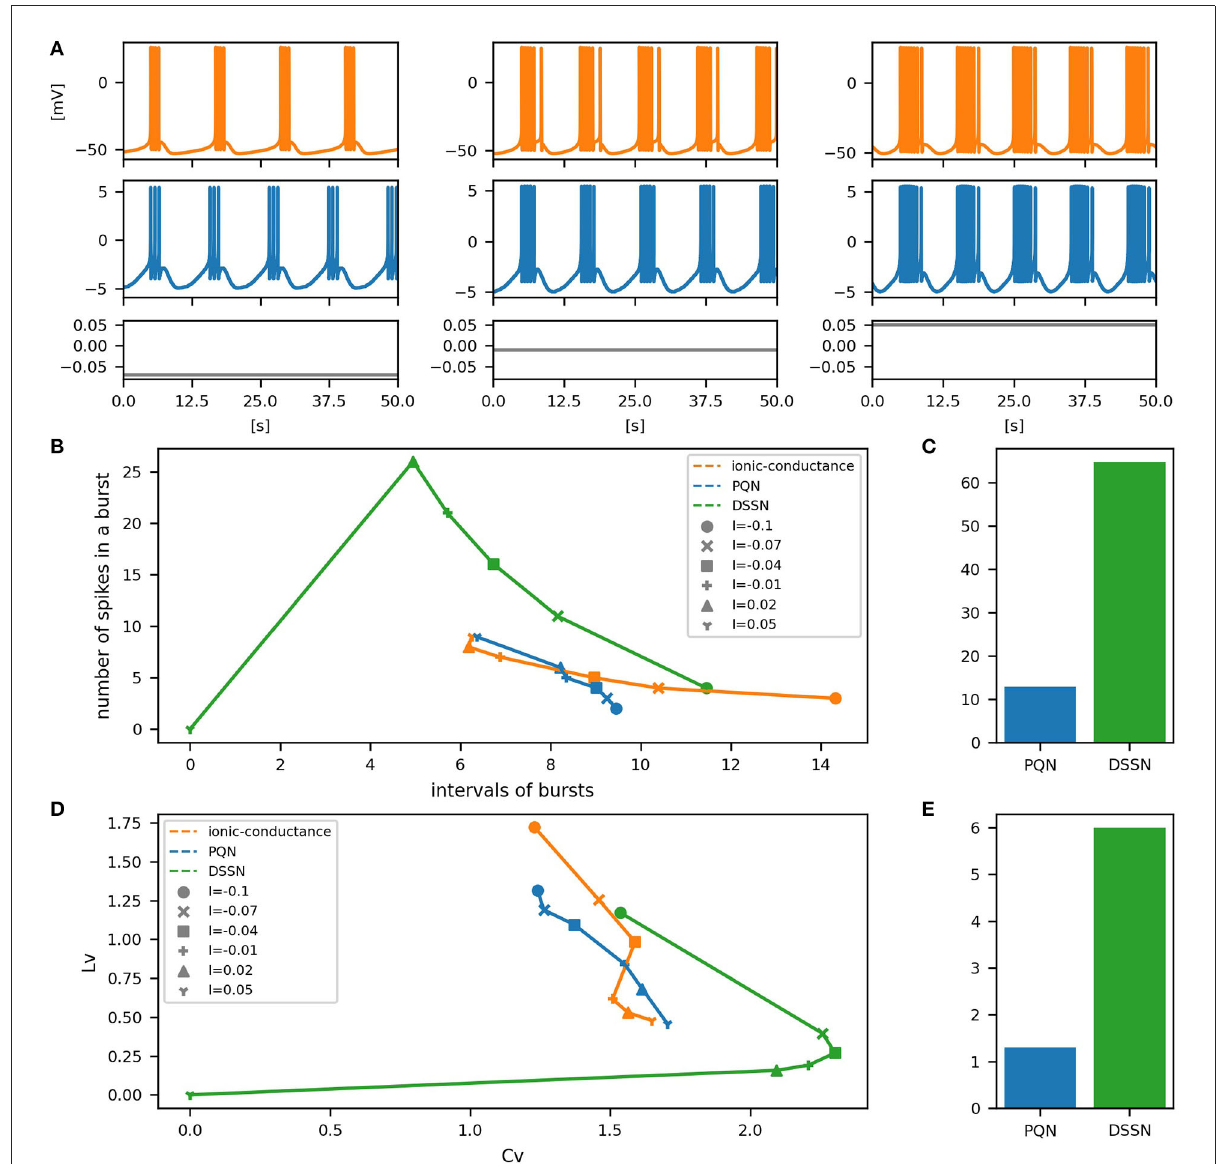
FIGURE12 Waveforms and spiking properties in PB mode. (A) Waveforms of the ionic-conductance model (orange) and the PQN model (blue). Gray lines represent stimulus inputs. (B) Properties of bursting. The horizontal axis represents the interval between bursts, and the vertical axis represents the number of spikes in a burst. Stimulus inputs were increased by 0.25 from 2.75 to 4.25. (C) The mean square errors of the PQN model and the DSSN model with the ionic-conductance model over the data points shown in (B) . (D) Values of the C V and L V were calculated from the waveforms and plotted while varying the magnitude of the stimulus inputs. (E) The mean square errors of the PQN model and the DSSN model with the ionic-conductance model over the data points shown in (D) .